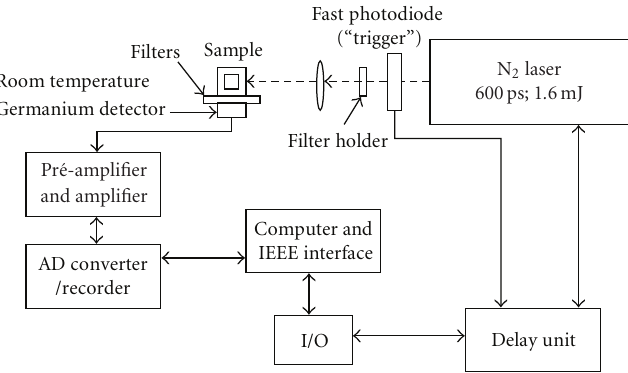
Figure 1: Experimental setup for the measurement of singlet oxygen emission at λ = 1270 nm.